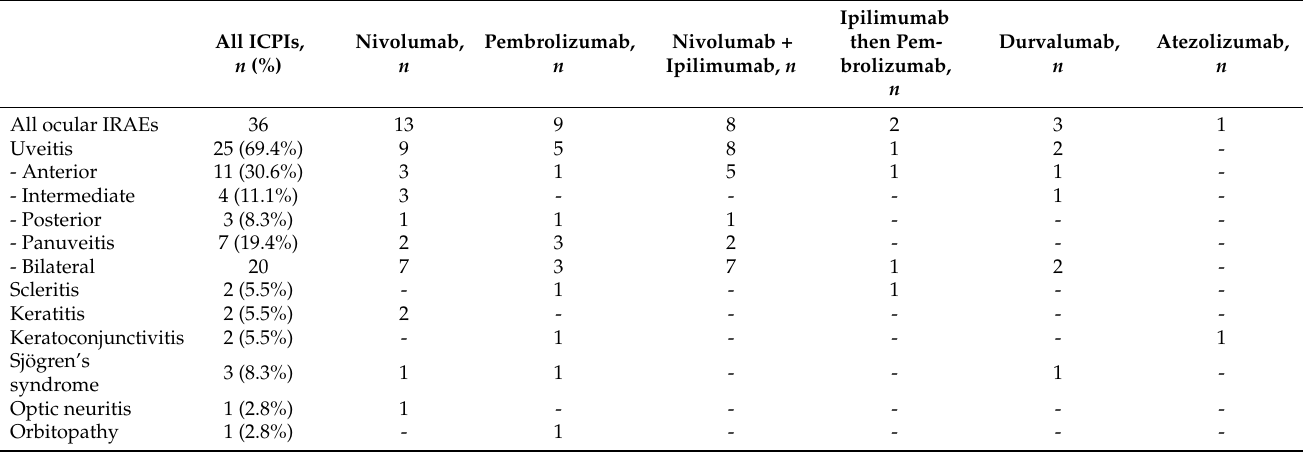
Table 2. Types of ocular IRAEs according to the